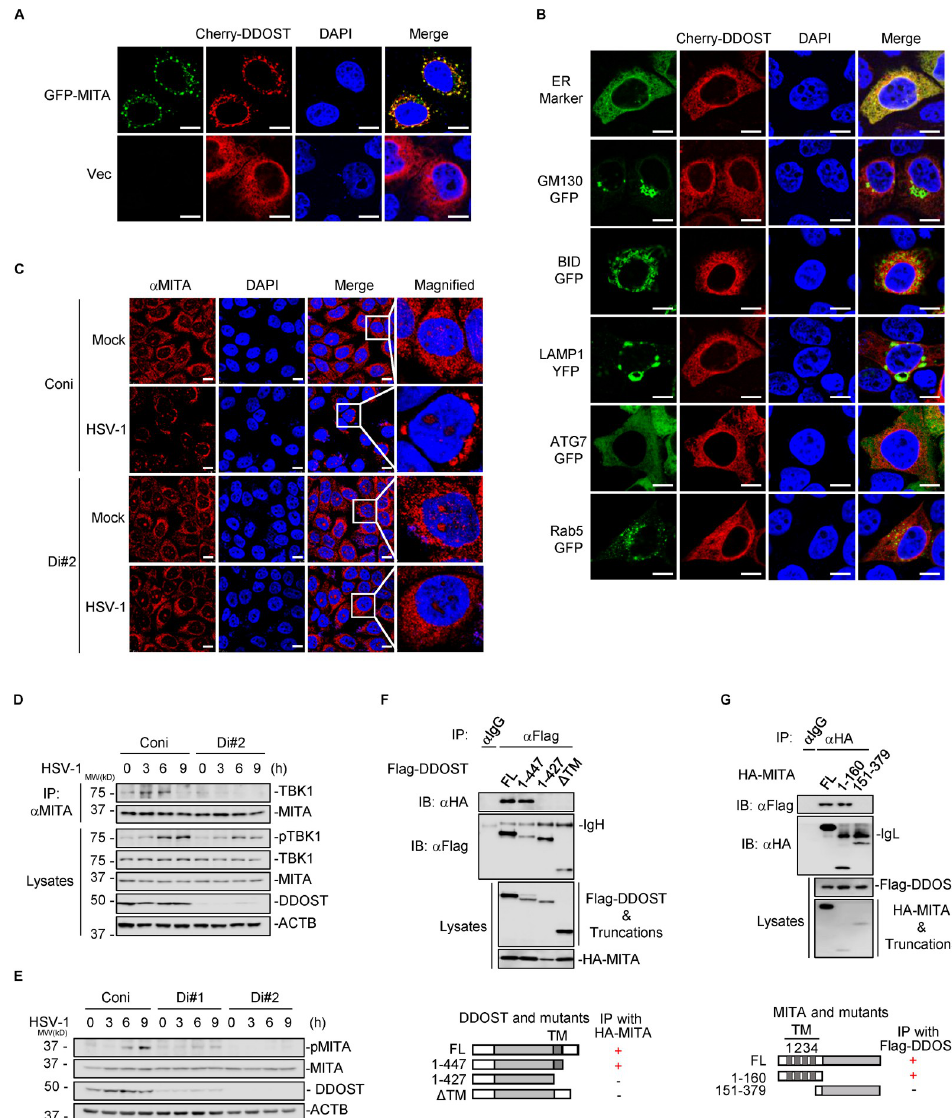
Fig 3. DDOST potentiates the function of MITA at the ER. (A, B) HeLa cells were transfected with Cherry-DDOST and GFP-MITA (A) or GFP-tagged organelle markers (B) and visualized under confocal microscopy 24 hours later. Vec: empty vector as a control; Scale bar: 10 μ m. (C) DDOST knockdown HaCaT cells and control cells were infected with HSV-1 (MOI = 2) for 3 hours before staining with rabbit anti-MITA and Cy3 goat anti-rabbit IgG. Scale bar: 10 μ m. (D) DDOST knockdown THP-1 cells and control cells were infected with HSV-1 (MOI = 2) for the indicated time. Cell lysates were subjected to Co-IP and immunoblotting analysis using the indicated antibody. (E) DDOST knockdown THP-1 cells and control cells were infected with HSV-1 (MOI = 2) for the indicated time before immunoblotting analysis. One representative result from at least three independent experiments is shown. (F, G) HEK293T cells were transfected with HA-MITA plus full length Flag-DDOST or its truncated mutants (F) or Flag- DDOST plus full length HA-MITA or its truncated mutants (G). Then, Co-IP and immunoblotting analysis were sequentially performed using the indicated antibodies 24 hours posttransfection. The related interaction diagrams are shown in the lower panels. FL: full length; TM: transmembrane domain; IgL: immunoglobin light chain. the ratio of N-glycosylated MITA peptide abundance to the total peptide abundance and found that HSV-1 infection potentiated N-glycosylation of MITA at N183, N211 and N242 (Fig 4E). However, in DDOST knockdown cells, virus-induced glycosylation at N183, N211,